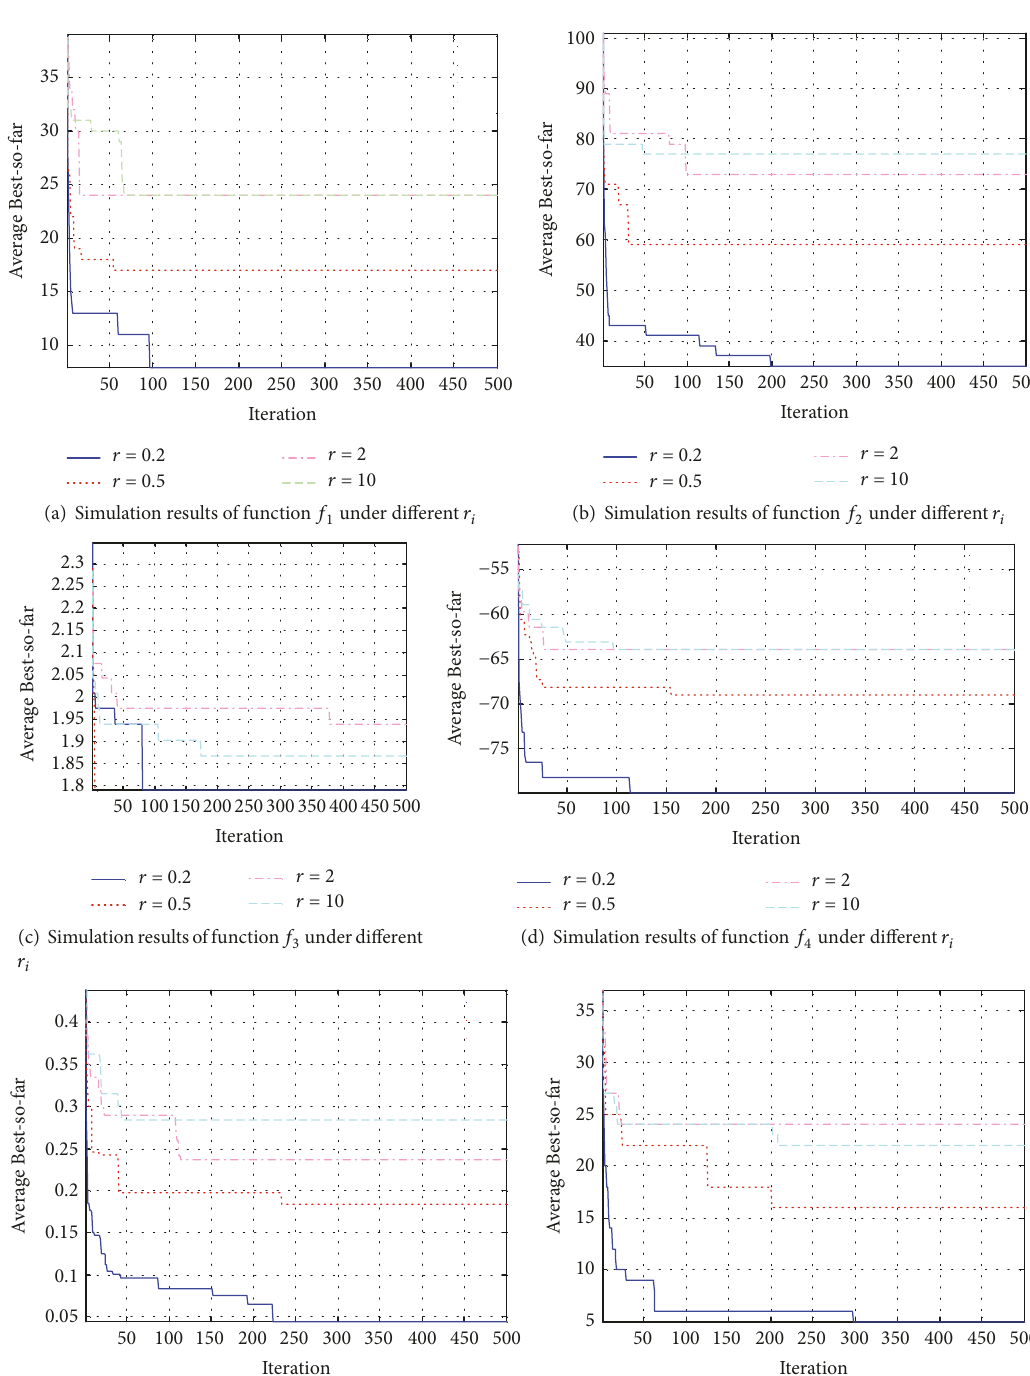
(f) Simulation results of function 𝑓 6 under different 𝑟 𝑖 Figure 4: Simulation results of BBA under different 𝑟 𝑖